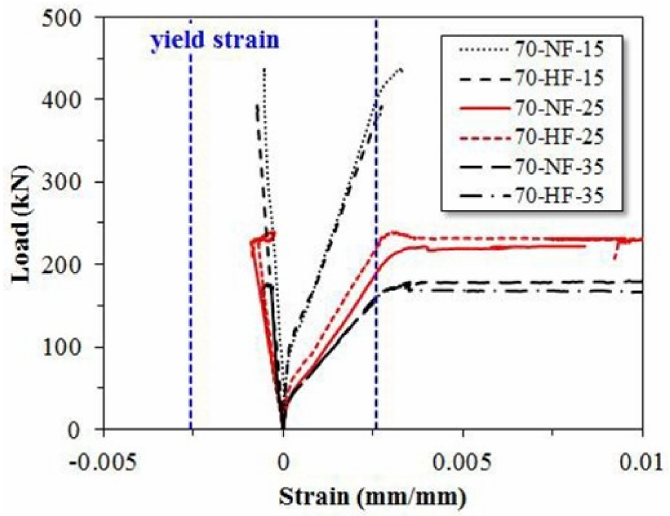
Figure 9. Effects of shear span ratio and steel fiber tensile strength on strain of tension and compres- sion